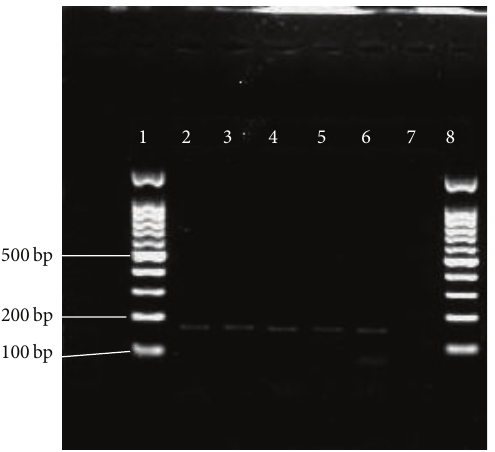
Figure 5: PCR results of efaAfm . 1, 8 = marker = 100 bp; 2–6 = efaAfm = 199bp; 7 = negative control.